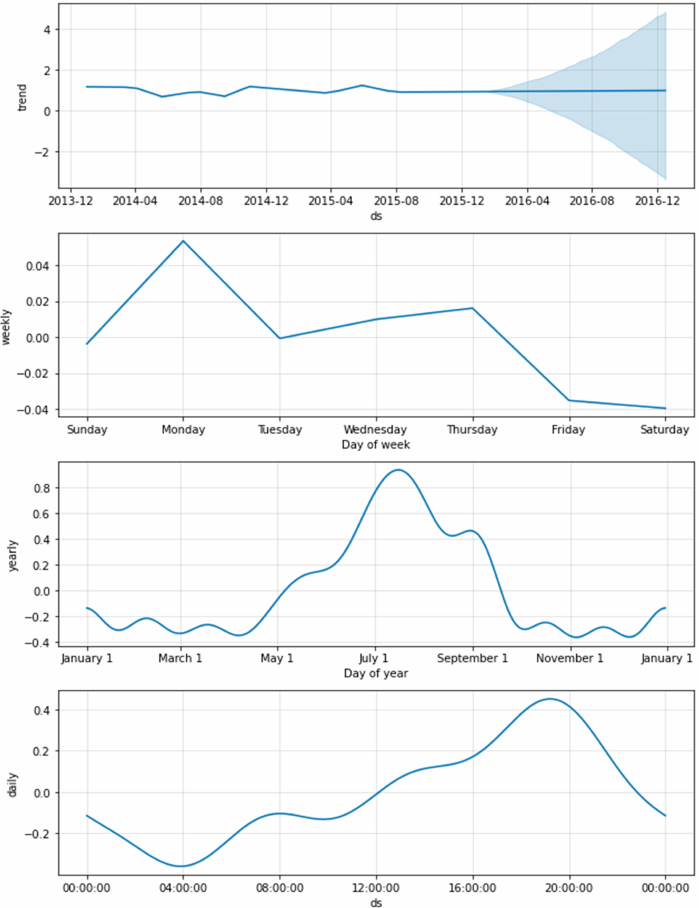
Figure 13. Charts (top to bottom): Trend, weekly, yearly and daily-datasets used in the Prophet